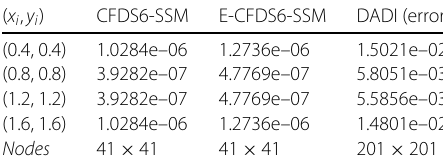
Table 1 The error of two different schemes for SP 1 at t = 1